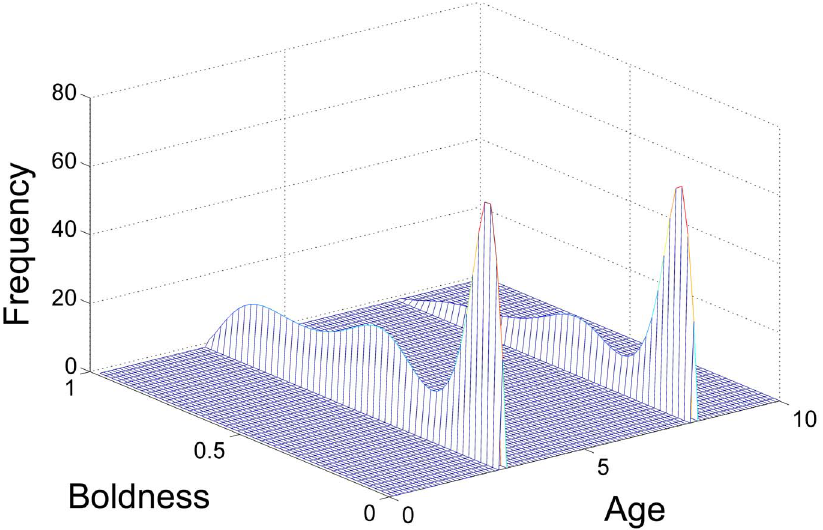
Figure 5. Periodic solutions of the system. The birth function was modified to b ( a , x ) ~ d ( a { 5) to gain a periodic solution. Individuals are clustered in cohorts, in which the shy-boldness distribution within the cohort changes over time.